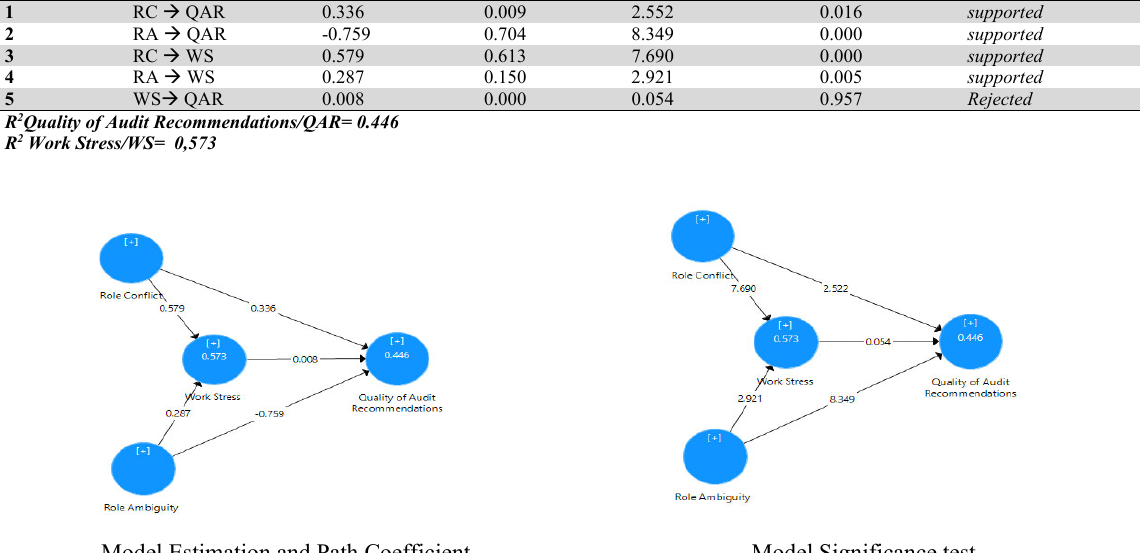
Fig. 1. The results of testing the